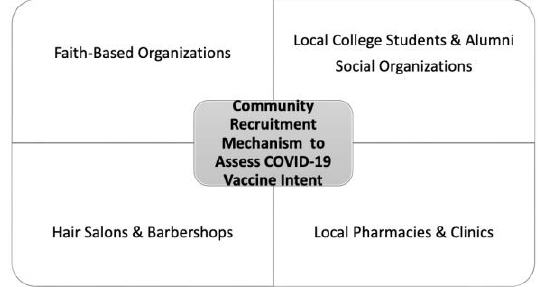
Figure 1. Community Recruitment Mechanism.